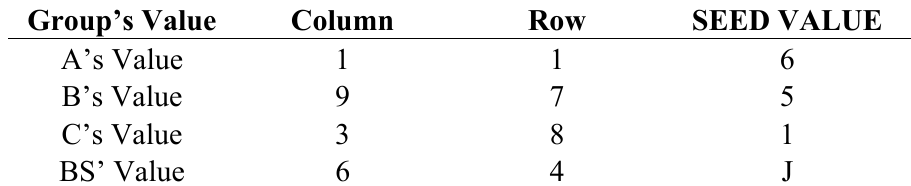
Table 1. Extracted Value to